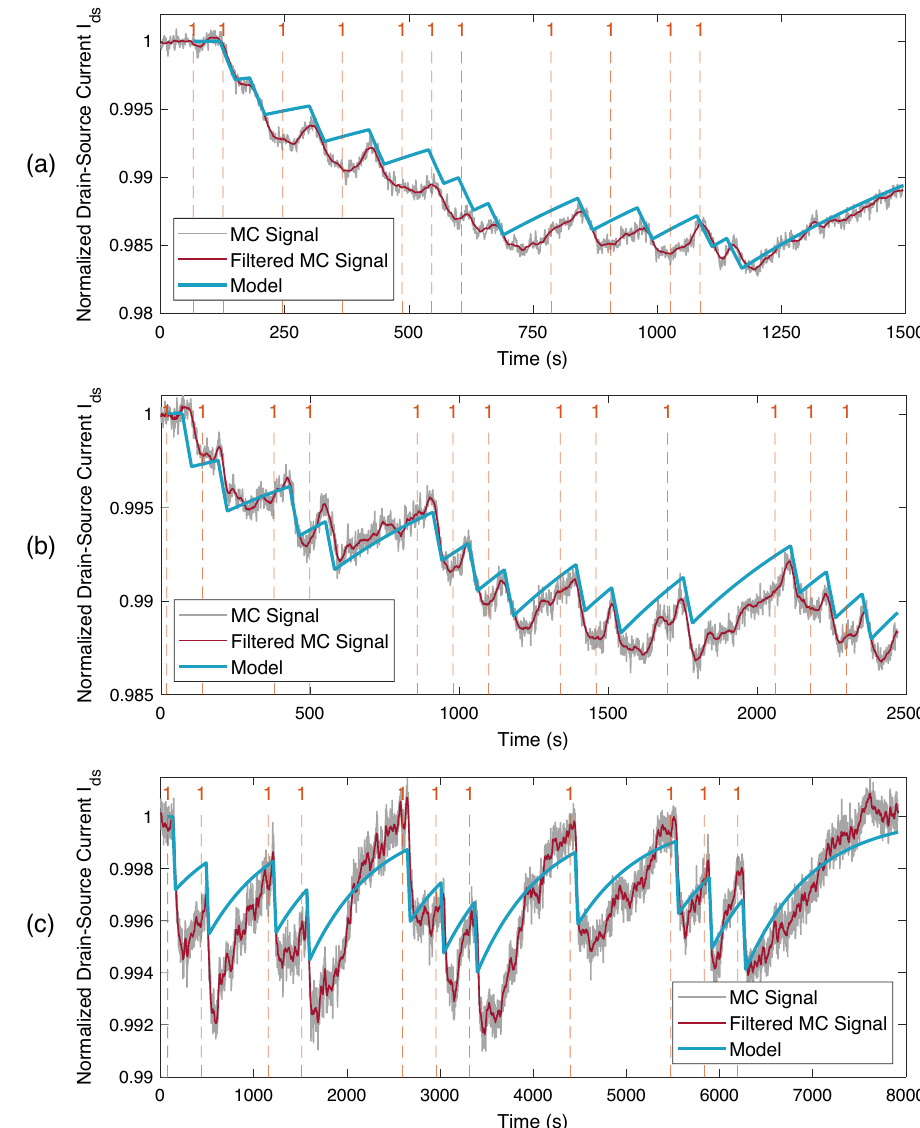
30 s and Figure 13. Normalised receiver response for binary data transmission with fixed pulse length T p = 60 s, ( b ) T 120 s, ( c ) T 360 s. The grey lines denote the received MC signals varying bit intervals: ( a ) T s s = s = = normalised by the baseline current, and the solid red lines are their low-pass filtered version by a moving average filter of 21-s length in MATLAB. Solid blue lines represent the normalised output of the model given in (17). Dashed orange lines indicate the time instants when bit-1 is transmitted, i.e., when the mechanical switch in the tDNA line is opened for 30